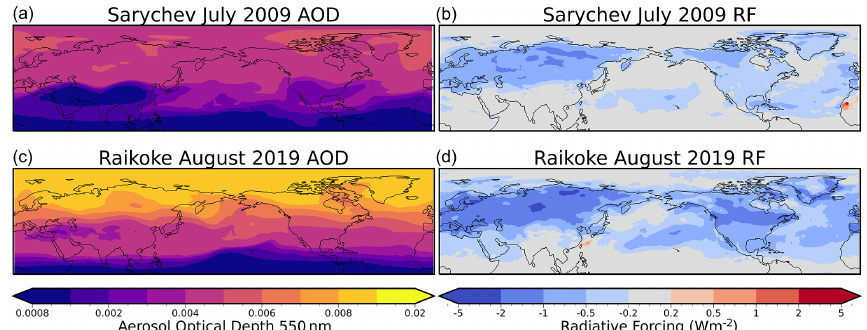
Figure 11. The sAOD for July at 550nm for (a) Sarychev Peak derived from HadGEM2 and (b) Raikoke derived from UKESM1. The cloud-free radiative forcing at the top of the atmosphere (Wm − 2 ) for (c) Sarychev Peak derived from HadGEM2 and (d) Raikoke derived from UKESM1. Table 4. The cloud-free global mean radiative forcing (in Wm − 2 ) at the top of the atmosphere for Sarychev Peak (after Haywood et al., 2010) derived from HadGEM2 and for Raikoke SO2only and SO2 + ash simulations derived from UKESM1. N/A indicates not available. Raikoke SO2only Raikoke SO2 + ash Sarychev Peak June − 0 . 001 − 0 . 004 − 0 . 03 July − 0 . 26 − 0 . 22 − 0 . 13 August − 0 . 29 − 0 . 25 − 0 . 07 September − 0 . 13 − 0 . 19 N/A October − 0 . 05 − 0 . 14 N/A November − 0 . 02 − 0 . 07